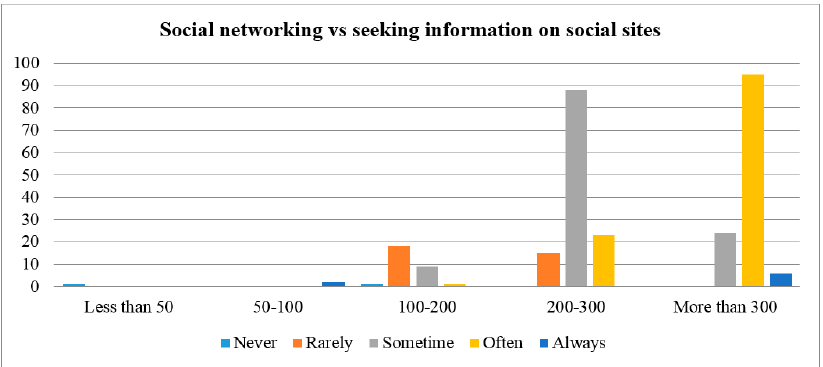
Figure 3. Number of online social connections versus SIS practices.